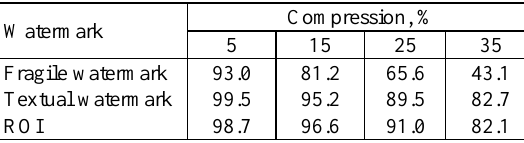
Figure 6. Watermark distortions under scaling attacks Watermark